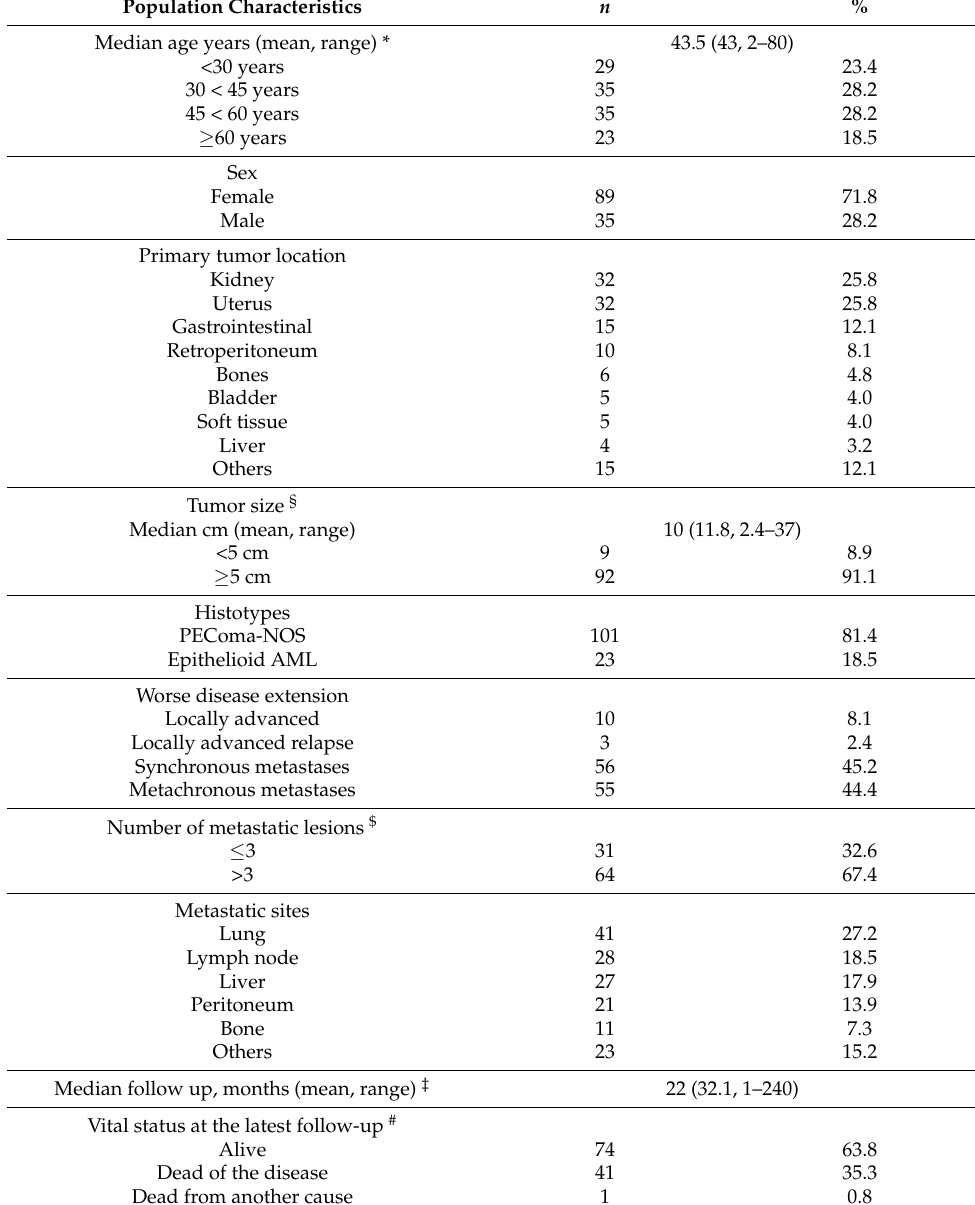
Table 2. Patients and tumor characteristics from individual case reports ( N =